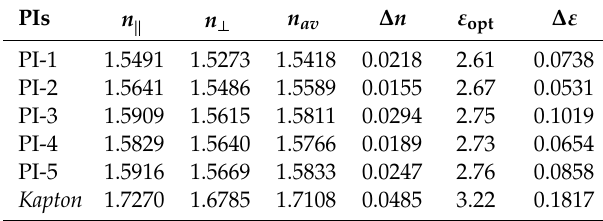
Table 4. Refractive indices and dielectric constant of semi-alicyclic polyimide films a .